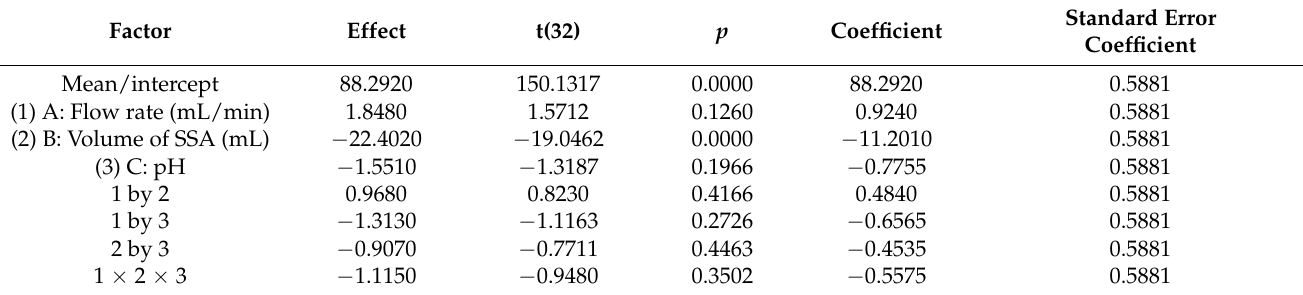
Table 8. Results of the statistical analysis for release efficiency in 6 h